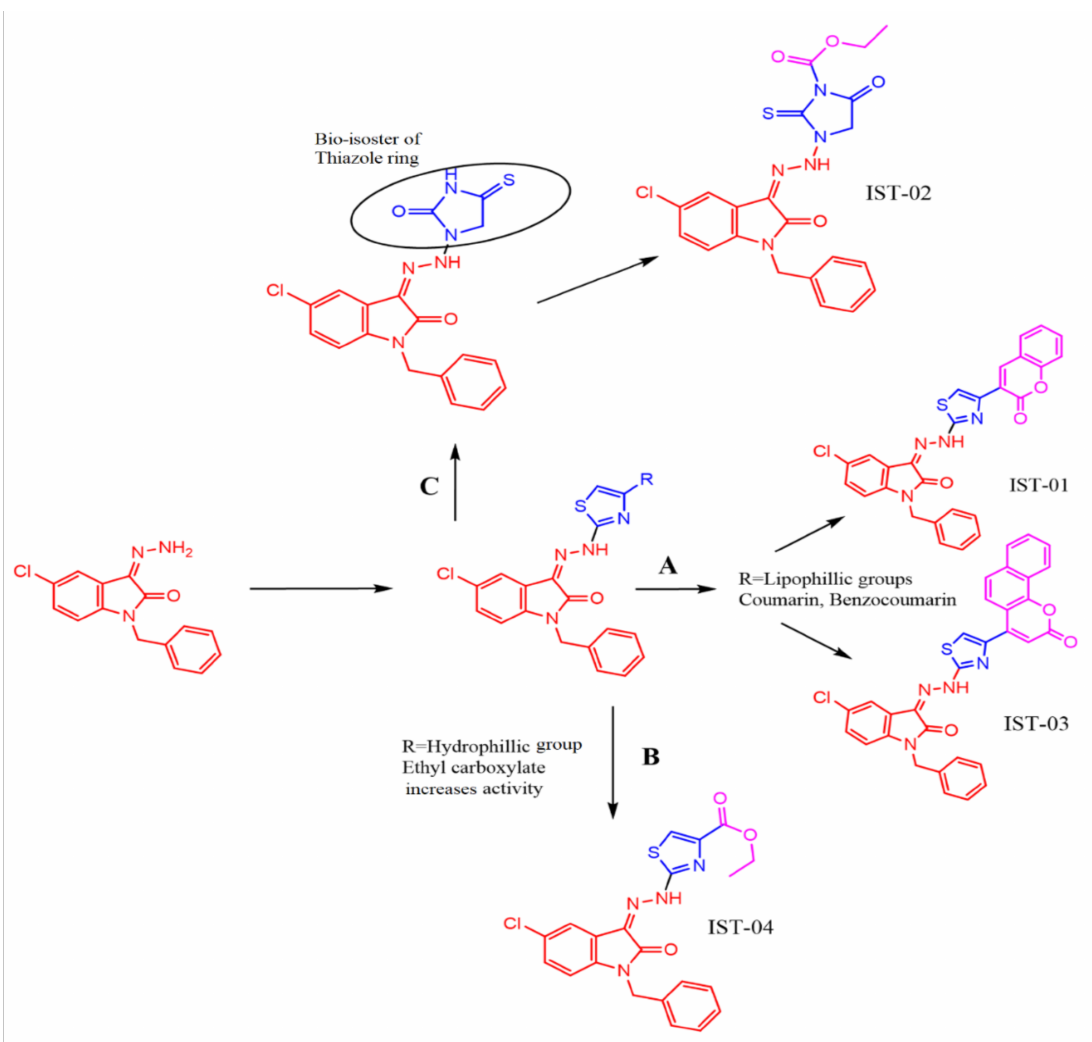
Figure 3. Pharmacological aspects of the structures. FT-IR analysis revealed that all synthesized compounds expressed characteristic ab- sorption band for N-H at 3233 cm − 1 , C-H aromatic at 3119 cm − 1 , C=O of carbonyl at 1738 cm − 1 , and C=N of imine at 1549 cm − 1 . The 1 H-NMR spectra of IST-01 showed NH proton at 13.34 ppm, coumarin proton at 8.63 ppm, thiazoline proton at 8.10 ppm. For IST-02, the 1 H-NMR spectra showed isatin proton at 8.03 ppm, phenyl proton as a mul- tiplet at 7.34–7.28 ppm, thiohydantoin proton at 4.97 ppm. For IST-03, 1 H-NMR spectra showed N-H proton at 12.88 ppm, thiazolidine proton as a multiplet at 7.58–7.25 ppm. For IST-04, 1 H-NMR spectra showed N-H proton at 13.24 ppm, thiazoline proton at 7.79 ppm. 13 C-NMR (75 MHz, CDCl δ (ppm), for IST-01 showed 165.61 (thiazole, C=N), 161.63 3 ) in (coumarin C=O), 152.99 (isatin C=O), 145.08 (imine, C). For IST-02, spectra showed 172.00 (thiohydantoin, C=S), 171.36 (thiohydantoin, C=O), 166.21 (ester C=O), 163.97 (isatin, C=O), 148.08 (imine, C). For IST-03, spectra showed 180.00 (thiazole, C=N), 161.63 (coumarin C=O), 160.80 (isatin C=O), 141.33 (imine, C). For IST-04, spectra showed 166.80 (ester, C=O), 161.35 (thiazole, C=N), 161.27 (isatin C=O), 144.21 (imine, C). All FT-IR, 1 H-NMR, and 13 C-NMR data was in good arrangement. The respective spectra are provided in Supplementary Materials as Figures